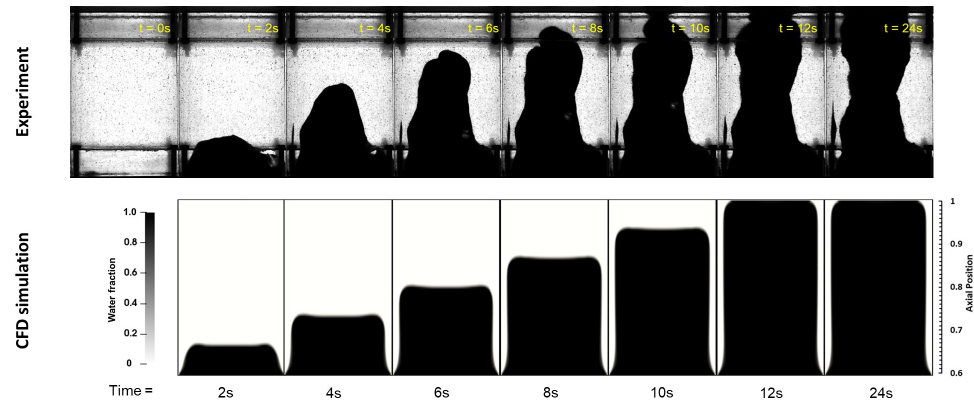
Figure 4. Experimental visualization ( top ) and CFD simulation ( bottom ) of interface evolution of water displacing 0.225 wt.% xanthan solution.